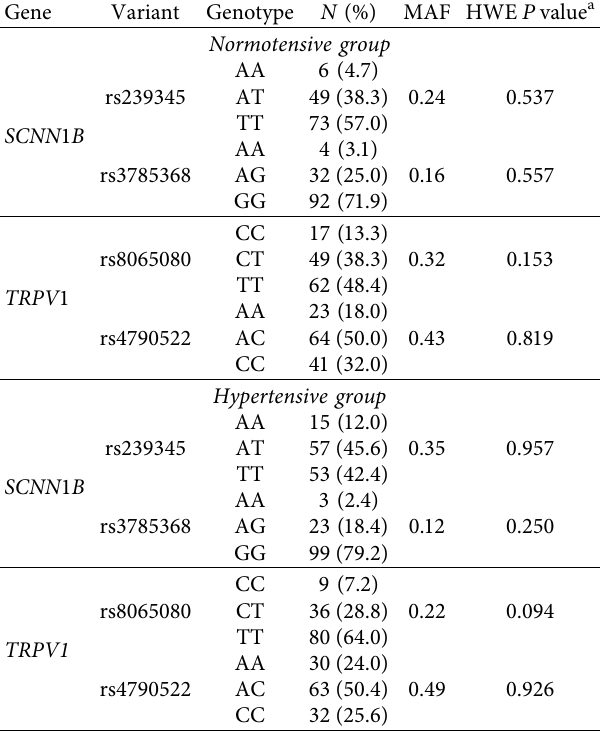
Table 4: Salt recognition thresholds across gender, age, race, and BMI within normotensive and hypertensive groups.